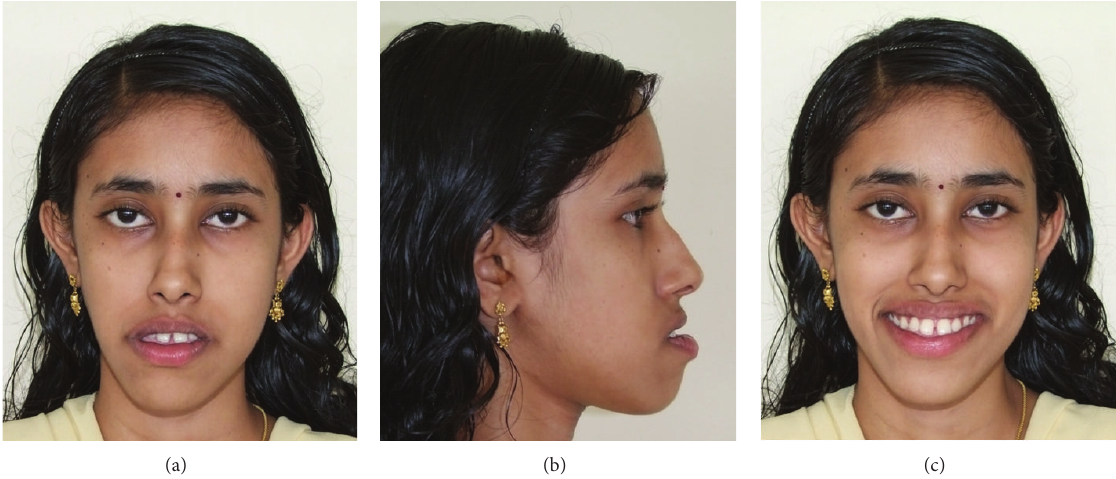
Figure 1: Pretreatment face: (a) frontal, (b) profile, and (c) smile.